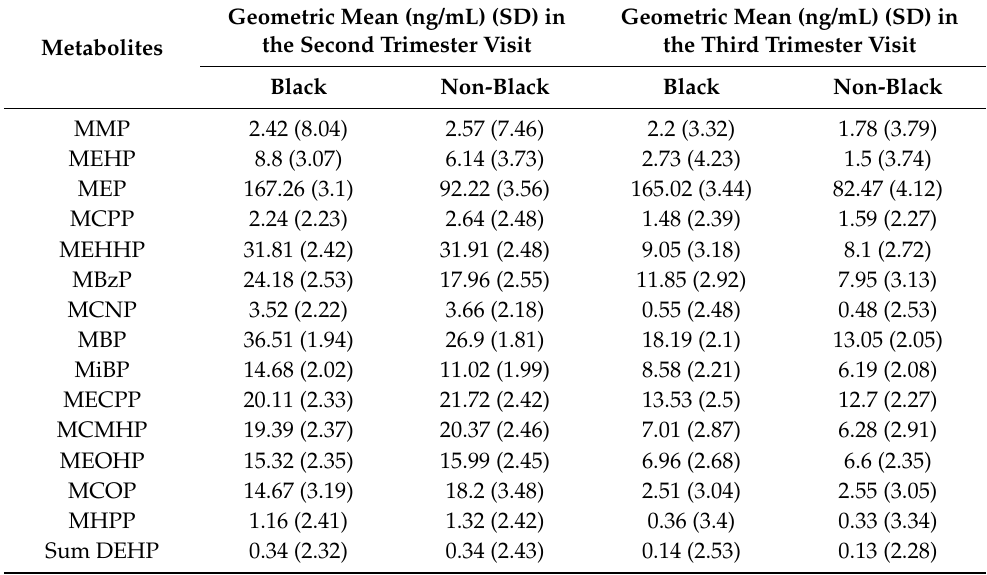
Table A2. Distributions of specific gravity adjusted urinary phthalate concentrations in CANDLE by maternal race.